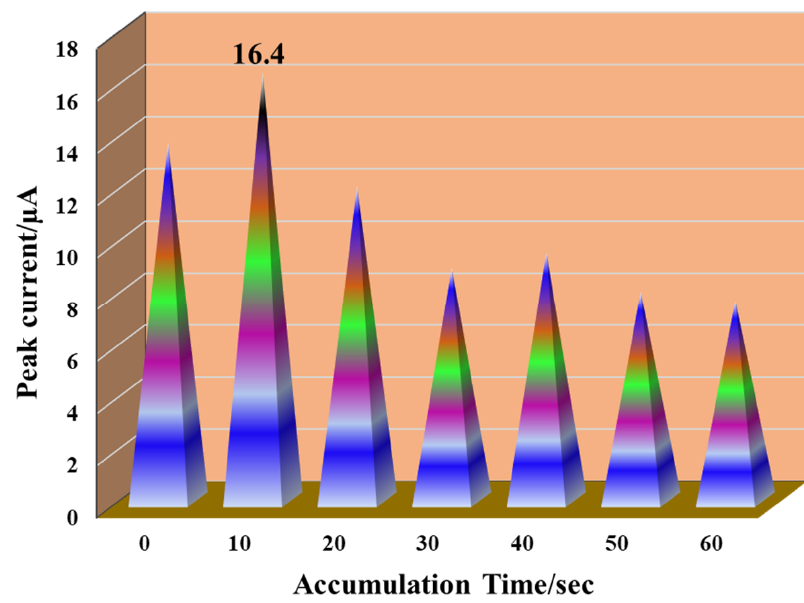
Figure 4. Effect of the accumulation time on THP (0.1 mM) in the CuO-GO/CPE.